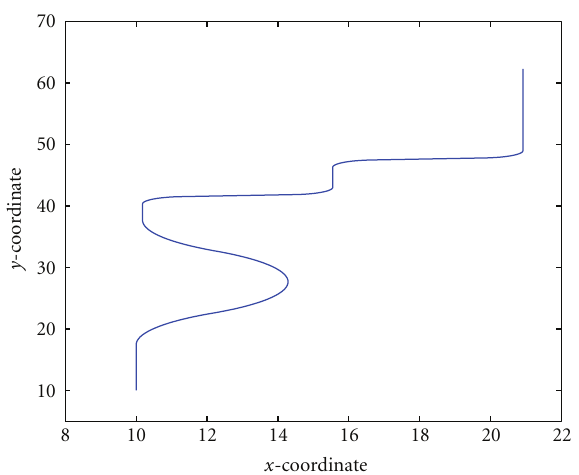
Figure 7: Simulation path for the IMM-CT, with distances in meters.